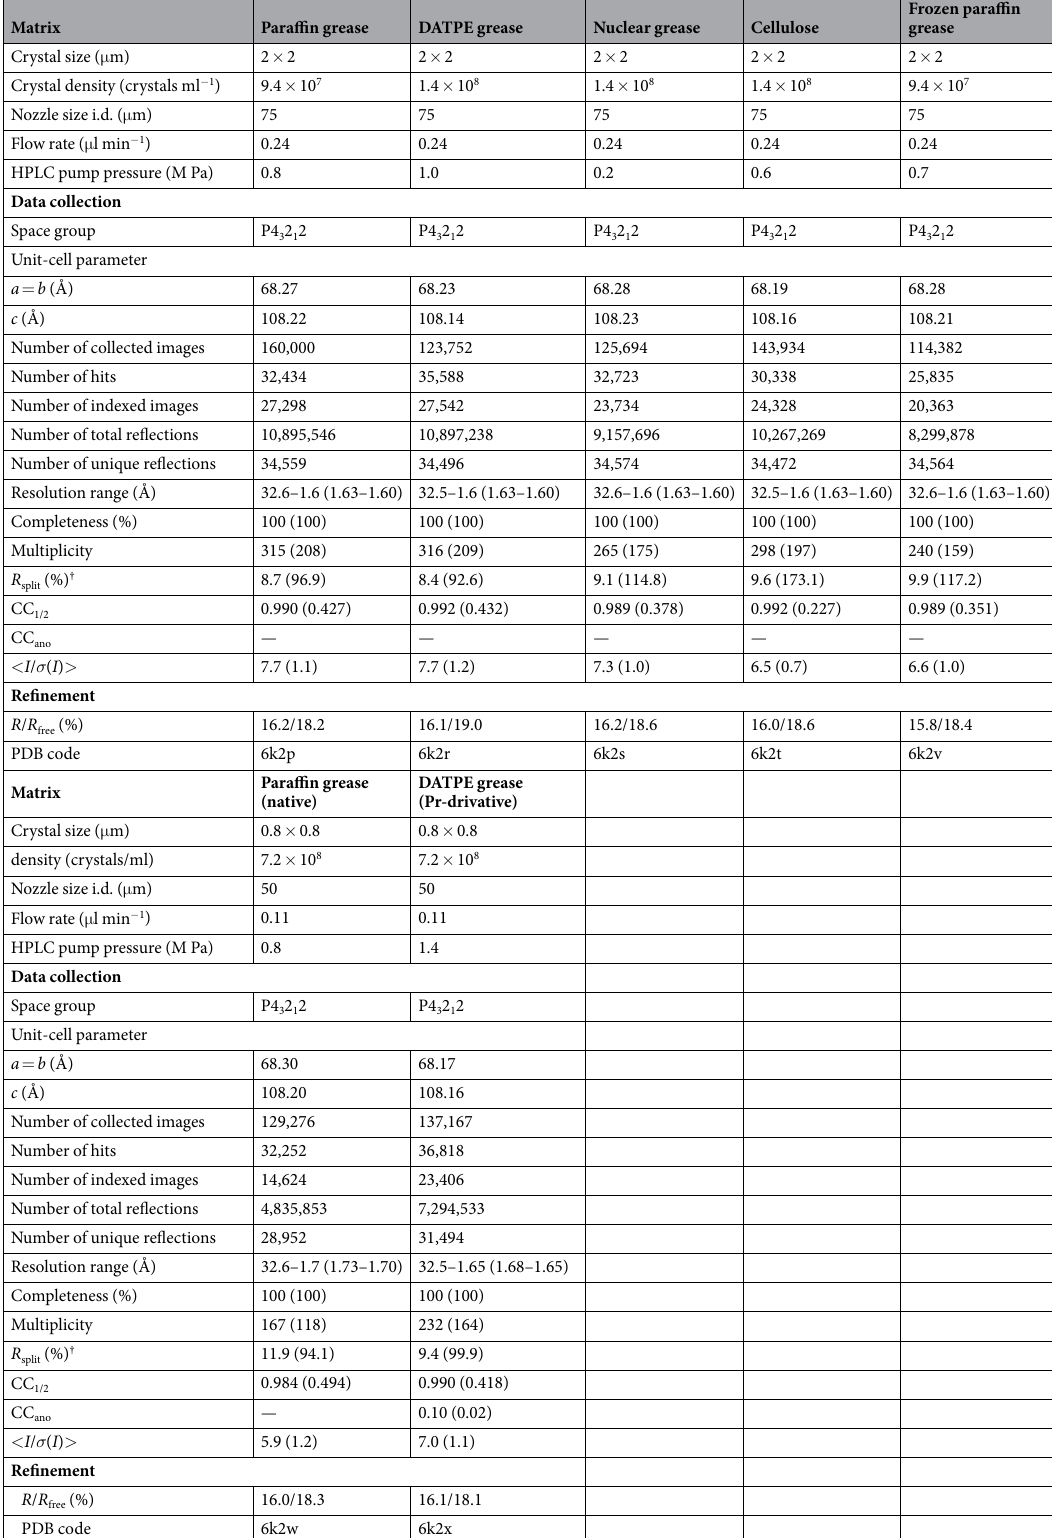
Table 1. Crystallographic statistics. Values in parentheses are for the outermost shell. † = ∑ − R 1/ 2 I I ∑ + I I